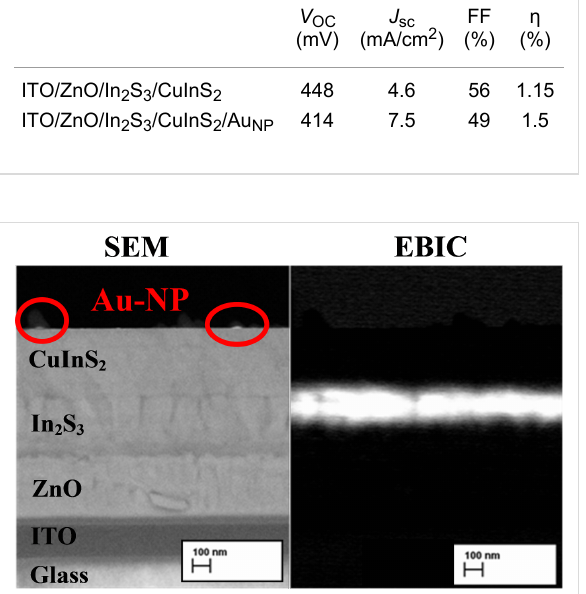
Figure 5: SEM image and EBIC image of the cross-section of the ZnO/In 2 S 3 /CuInS 2 /Au-NP solar cell prepared by spray pyrolysis on ITO/glass substrates. The Au-NP layer was deposited using 2.5 mL of the Au-precursor solution sprayed onto the CuInS 2 layer at 260 °C. The images were acquired simultaneously from the same location on the